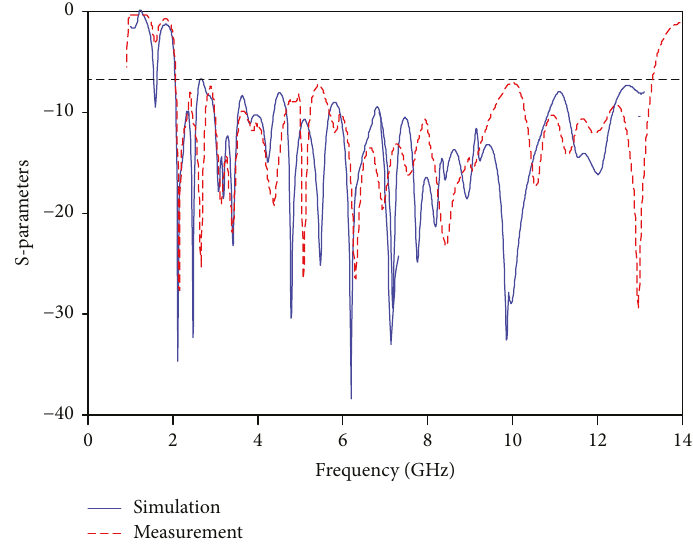
Figure 7: Simulated and measured port re fl ection for the assembled